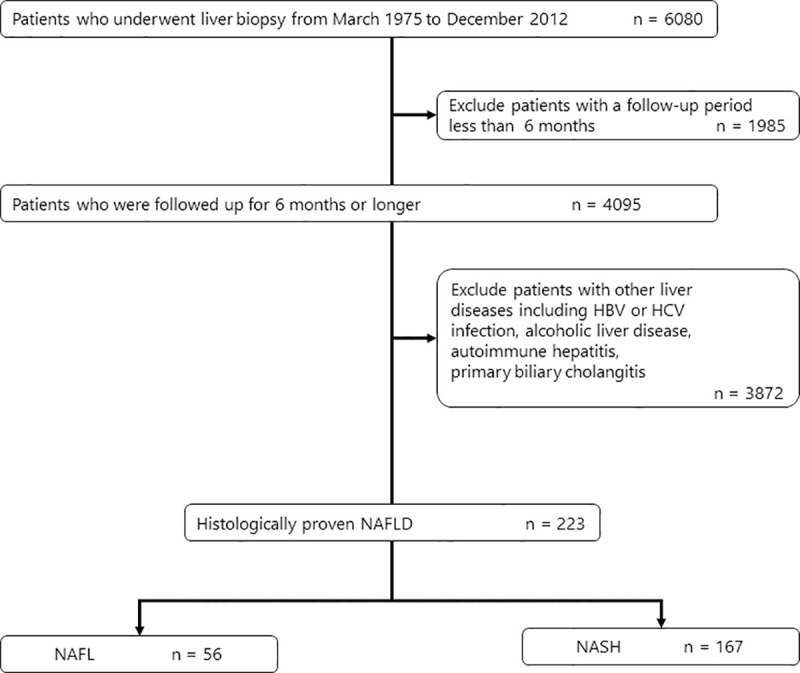
Algorithm of patient selection.NAFLD, nonalcoholic fatty liver disease; NAFL, nonalcoholic fatty liver; NASH, nonalcoholic steatohepatitis.